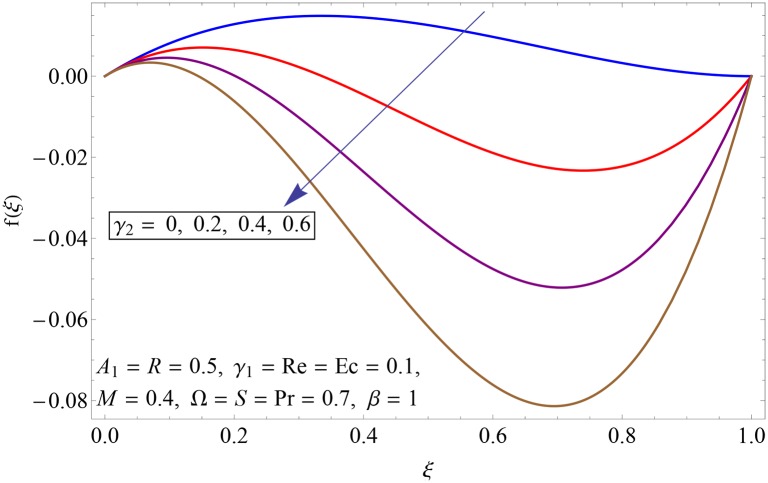
Impact of γ2 on f(ξ).